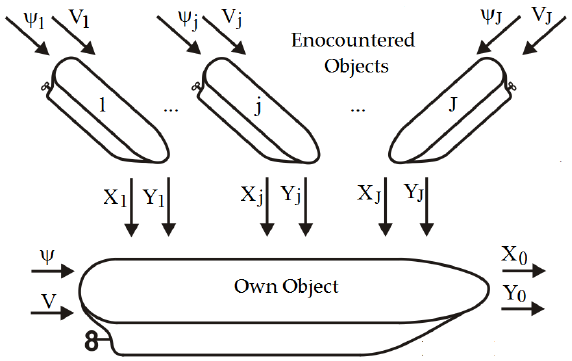
Figure 2. Block diagram of the positional game model in the situation with passing objects.